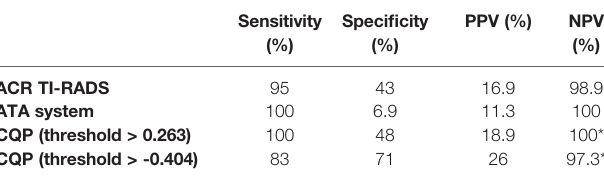
TABLE 5 | Sensitivity, speci fi city, positive predictive value (PPV) and negative predictive value (NPV) of ACR TI-RADS, ATA system and CQP